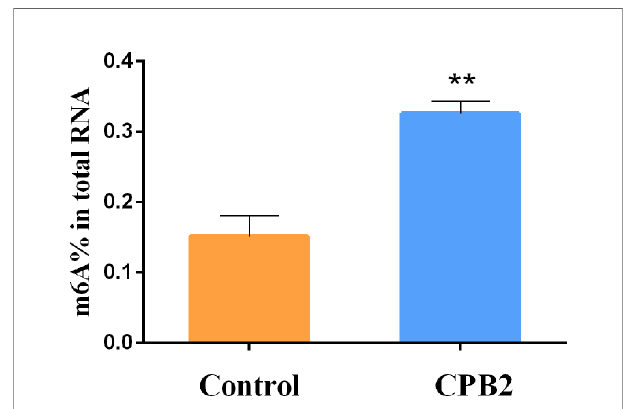
FIGURE 1 | The total m6A content in the CPB2-treated IPEC-J2 cells ** means P <